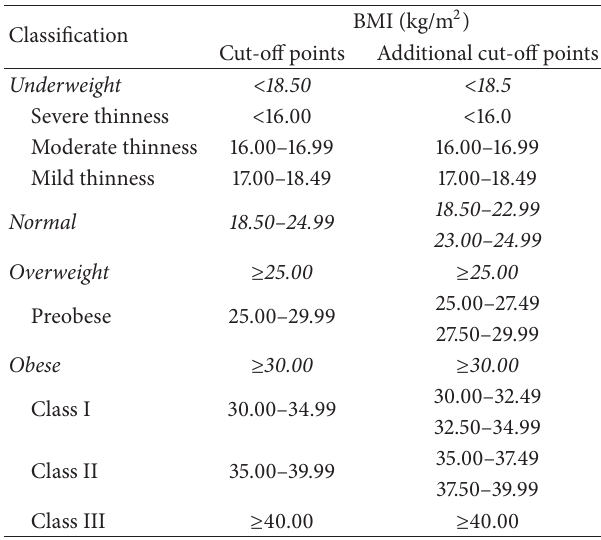
Table 4: International classification of adults based on body mass